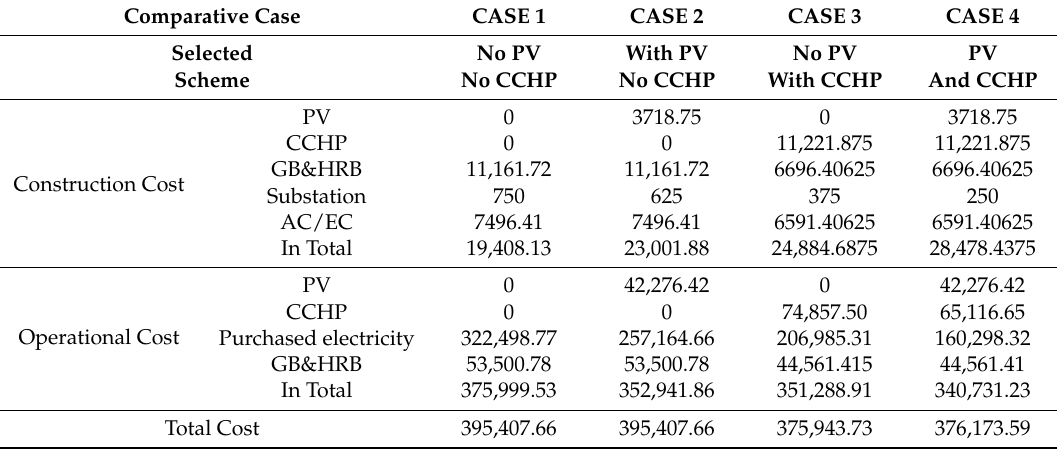
Table 3. Cost comparison of the different case study